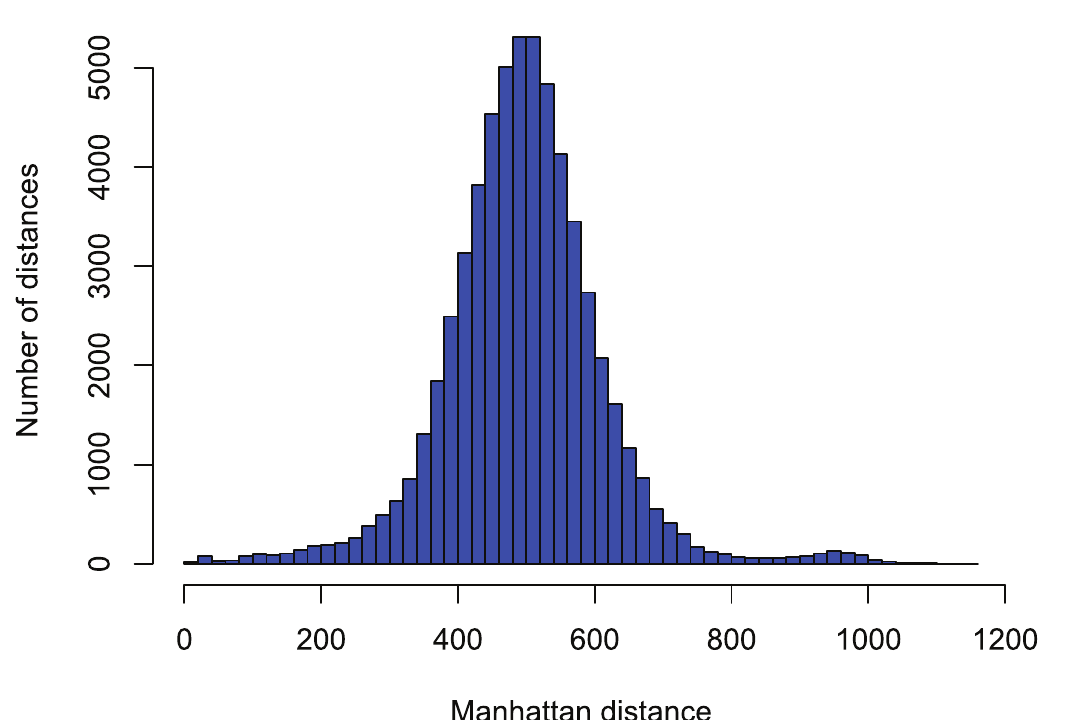
Figure 5. Functional distances. A histogram over all pairwise Manhattan distances between the genomes. The distance between two genomes is defined as the number of domain sequence families they differ in presence/absence status, i.e. a distance of 500 means there are 500 different families contained in one but not the other genome.